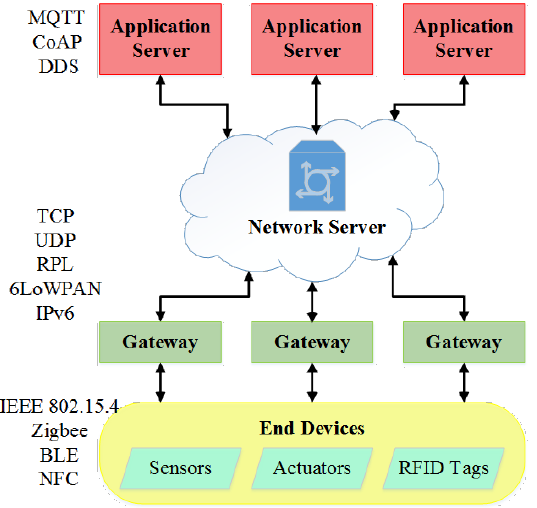
Figure 15. IoT connectivity